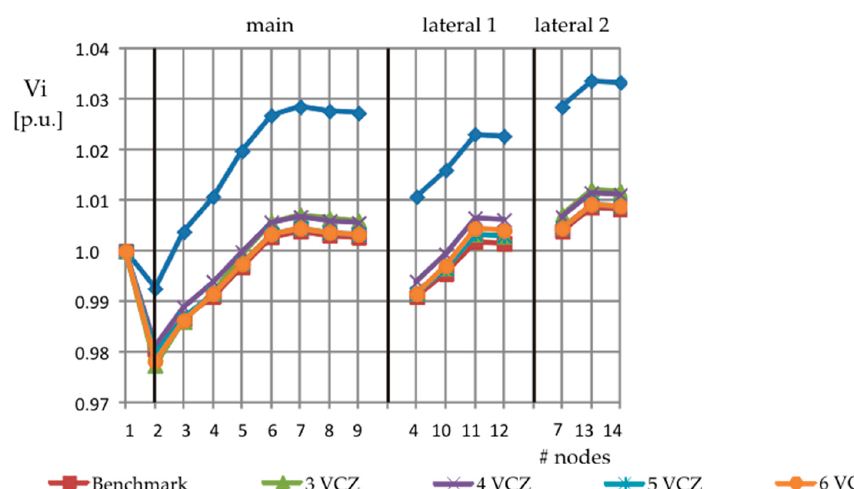
Figure 4. Voltage profiles for Case R —DG: P algorithm—feeder 1. Figure 4 : Voltage profiles for Case R — DG: P algorithm—feeder 1. Figure 4 : Voltage profiles for Case R — DG: P algorithm—feeder 1.